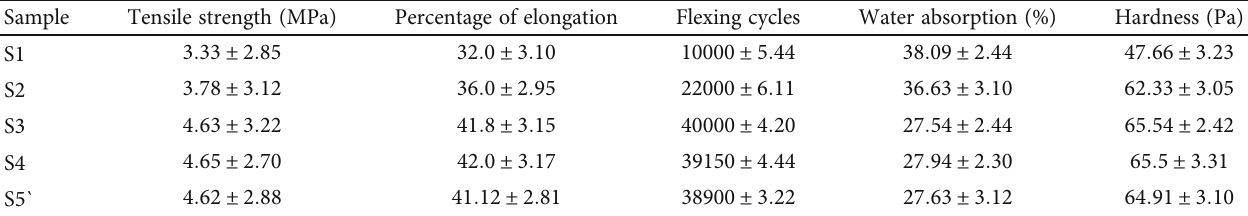
Table 1: Mechanical properties of pure bu ffi ng dust and various composites. Sample Tensile strength (MPa) Percentage of elongation Flexing